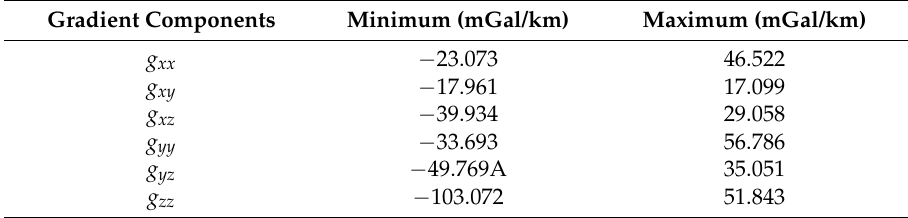
Table 2. The value of the gravity gradient tensor in Suli and Tulehu geothermal areas. Gradient